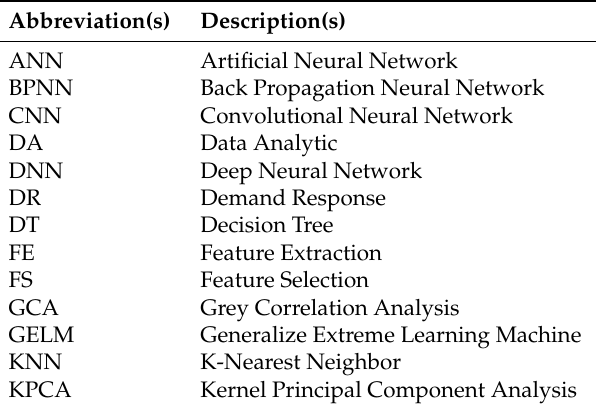
Table 9. Table of